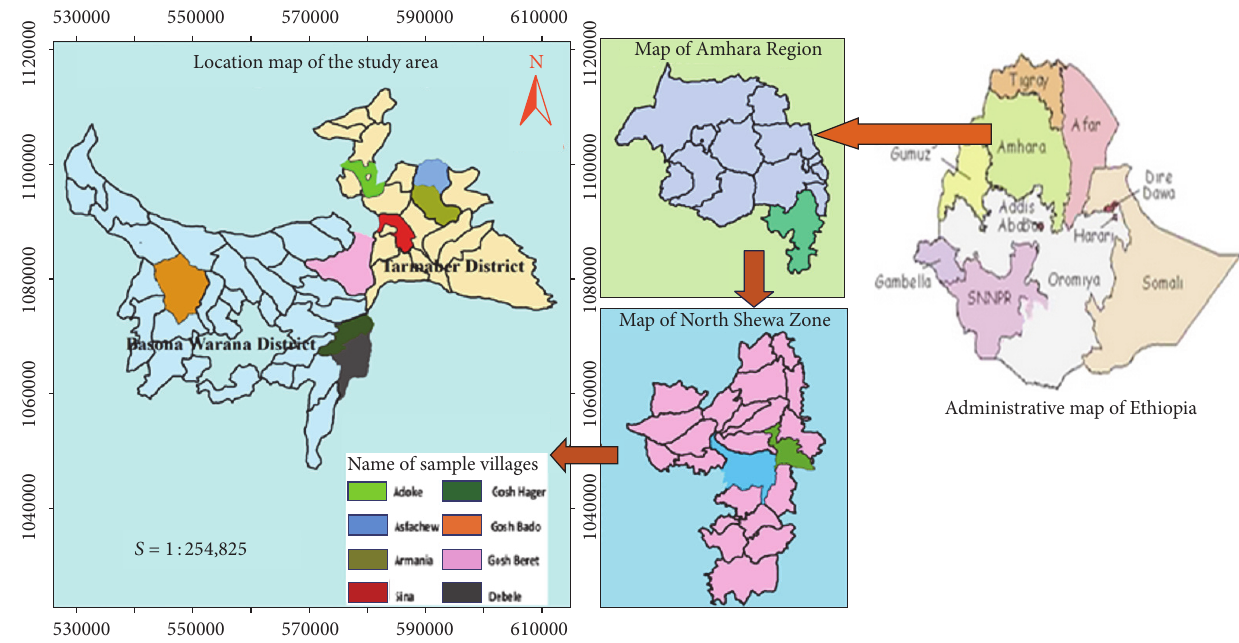
Figure 1: Map of the study